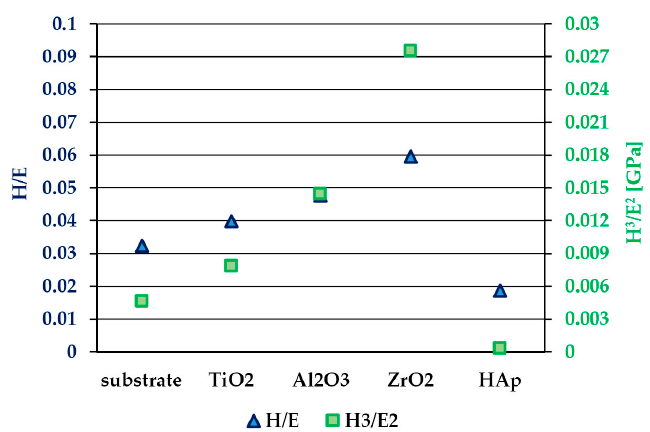
Materials 2020 , 13 , 502 / E and H 3 / E 2 ratios results for all the investigated samples. Figure 11. H/E and H 3 /E 2 ratios results for all the investigated samples. Figure 11. H